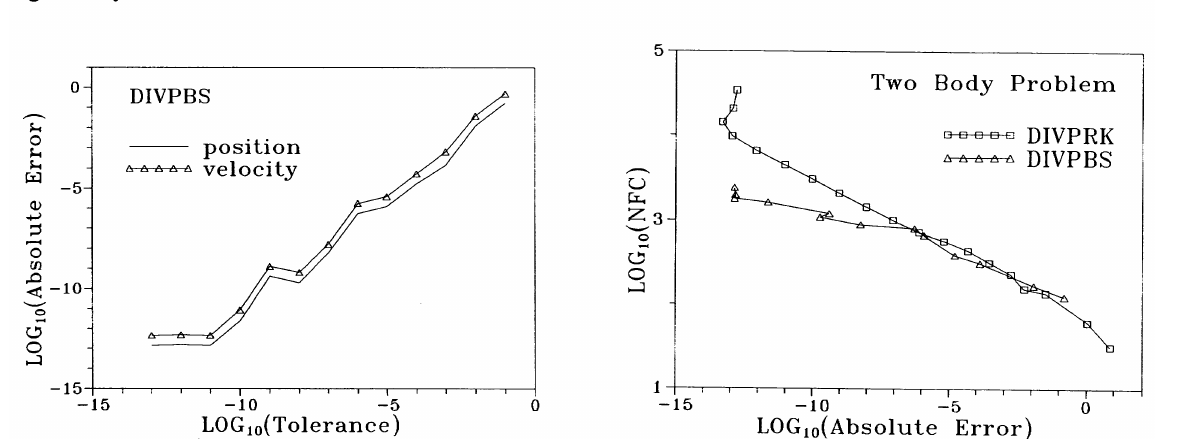
FIGURE 15 Number of function calls vs. absolute